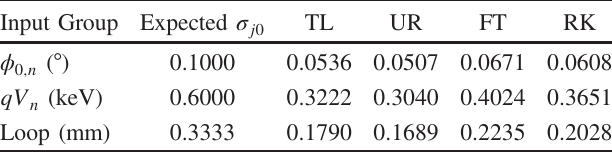
TABLE IV. Error tolerance ranges for cavity phase, voltage, and return loop length, as calculated using Eq. (31) with expected σ j 0 fluctuations on all input parameters. For a system that can feasibly achieve and maintain operation within predefined objective bounds, the input tolerance should be larger than expected σ j 0 .